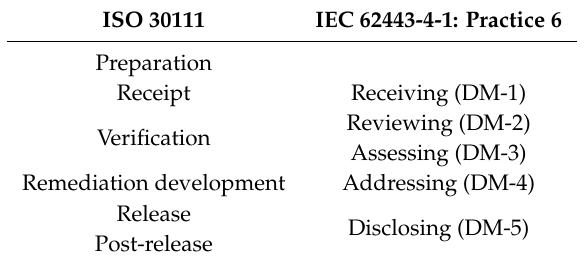
Table 4. Mapping ISO 30111 [44] and IEC 62443-4-1: Practice 6